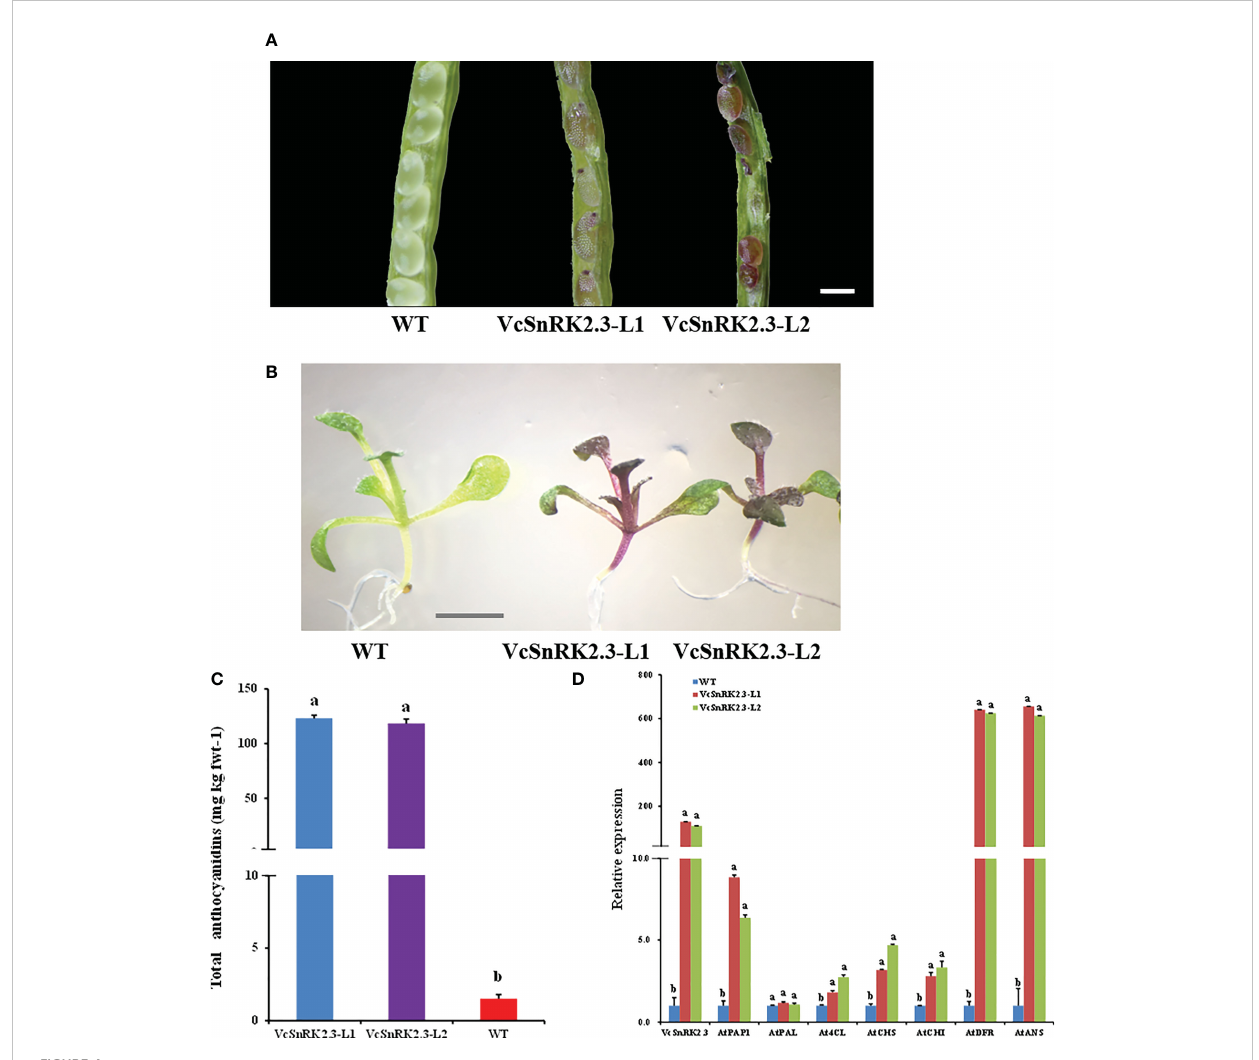
FIGURE 4 Functional analysis of VcSnRK2.3 in a heterologous system. (A) Seeds of Arabidopsis thaliana (ecotype Columbia) plants wild-type (WT) and overexpressing 35S: VcSnRK2.3 ( VcSnRK2.3 -L1, L2). Scale bar = 1 mm. (B) Arabidopsis plants wild-type and overexpressing 35S: VcSnRK2.3 ( VcSnRK2.3 -L1, L2). Scale bar = 5 mm. (C) Anthocyanin contents of Arabidopsis plants overexpressing 35S: VcSnRK2.3 ( VcSnRK2.3 -L1, L2) and the wild-type. Different asterisks above the bars indicate signi fi cant differences based on a t-test ( P < 0.01). Values are the means + SD of